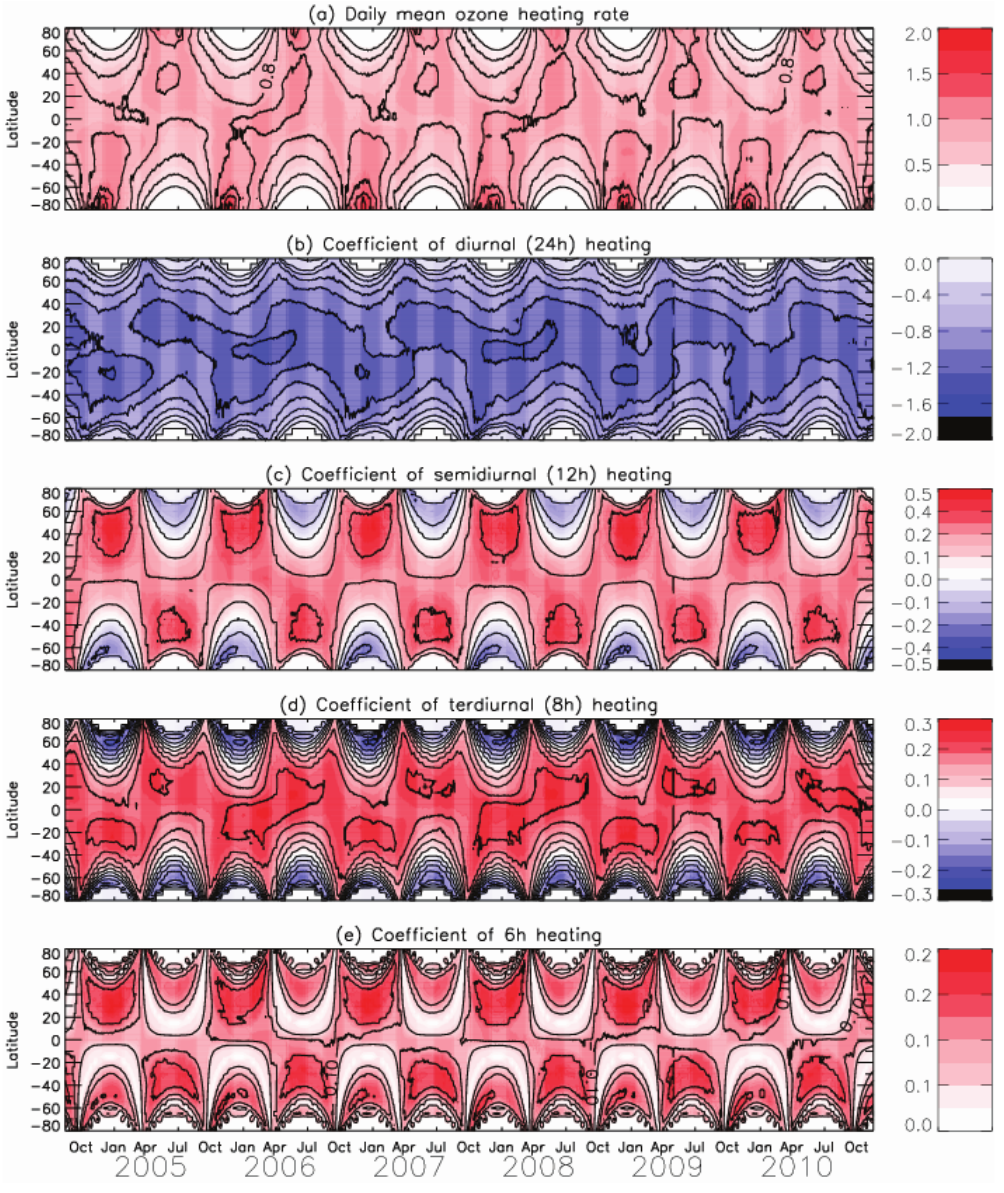
Fig. 4. The same as Fig. 3 but for the altitude of